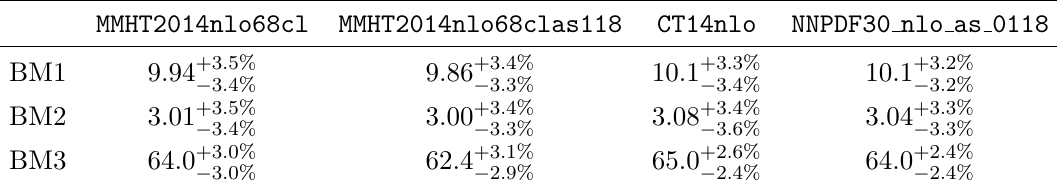
Table 4. Cross section (in fb) of ~ u L ~ u R production for the benchmark points of table 2 using di(cid:11)erent PDF sets. The (cid:12)rst set is the standard NLO PDF of this paper. The other columns compare di(cid:11)erent PDF sets at (cid:11) s ( m Z ) = 0 : 118. The factorisation and renormalisation scale are set to the common squark mass. All uncertainties are given at 68% CL. For this the uncertainties of the CT14 set have been rescaled by 1 : 642 as the default is given at 90% CL [104].